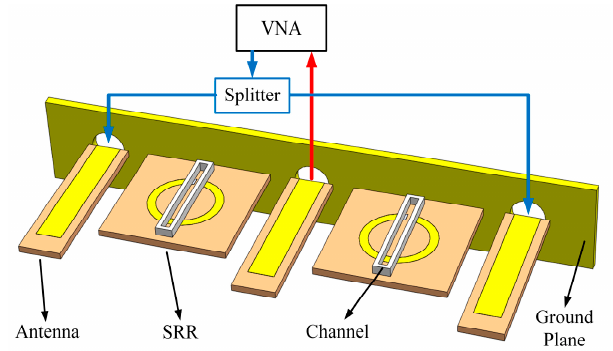
Figure 2. A schematic description of the measurement setup.